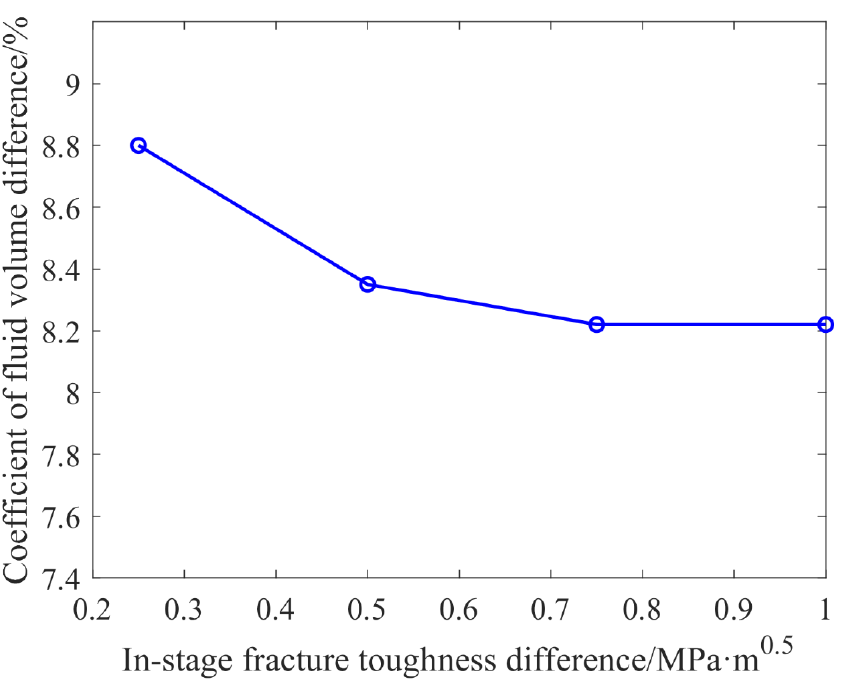
Figure 13. Relationship between the variation coefficient of fluid allocation and fracture toughness difference between clusters.